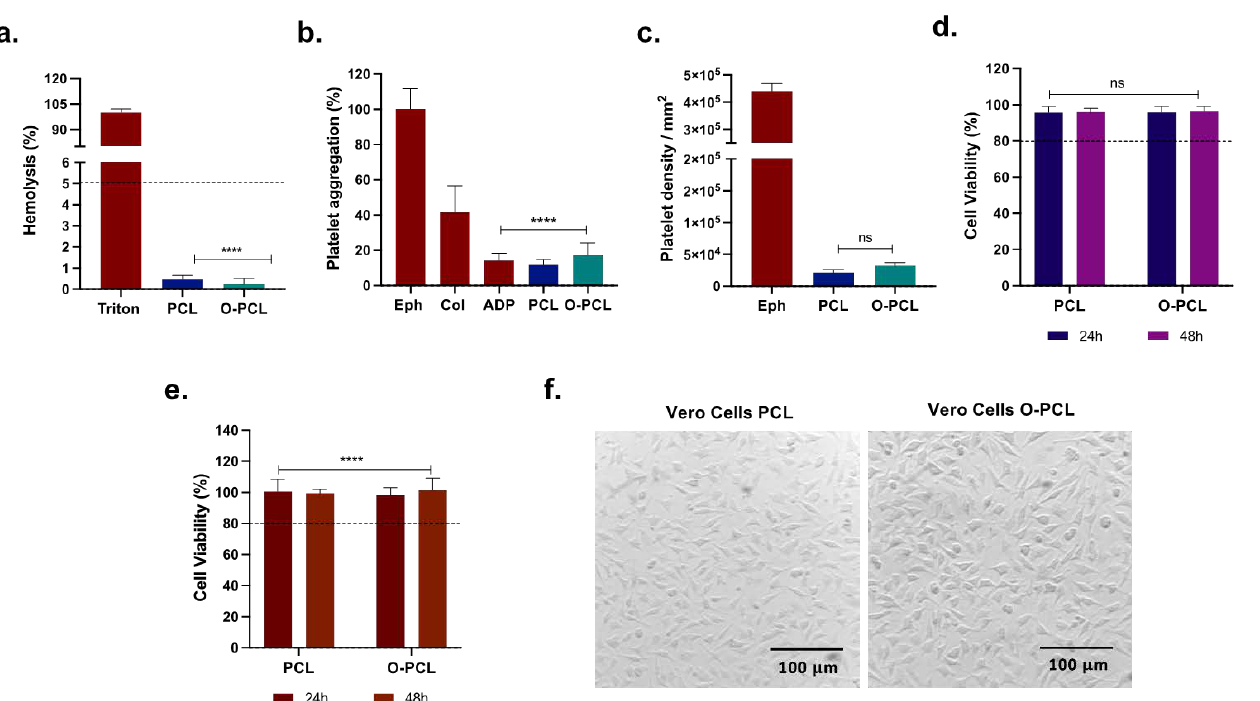
Figure 3. Biocompatibility assessment of the O-PCL. ( a ) Hemolytic behavior after an incubation time of 1 h. Triton X-100 and PBS were used as positive and negative controls. ( b ) Platelet aggregation assay. Epinephrine (Eph), collagen (Col), and adenosine diphosphate (ADP) were used as high, medium, and low aggregating references, respectively. ( c ) LDH platelet aggregation assay after 1 h of blood plasma exposure. ( d ) MTT and ( e ) LDH cytotoxicity in Vero cells after 24 and 72 h of exposure to the materials, ( f ) images of Vero cells seeded over PCL and O-PCL after 72 h of exposure. (ns is p > 0.05, * is p ≤ 0.05, ** is p ≤ 0.01, *** is p ≤ 0.001 and **** is p ≤ 0.0001)